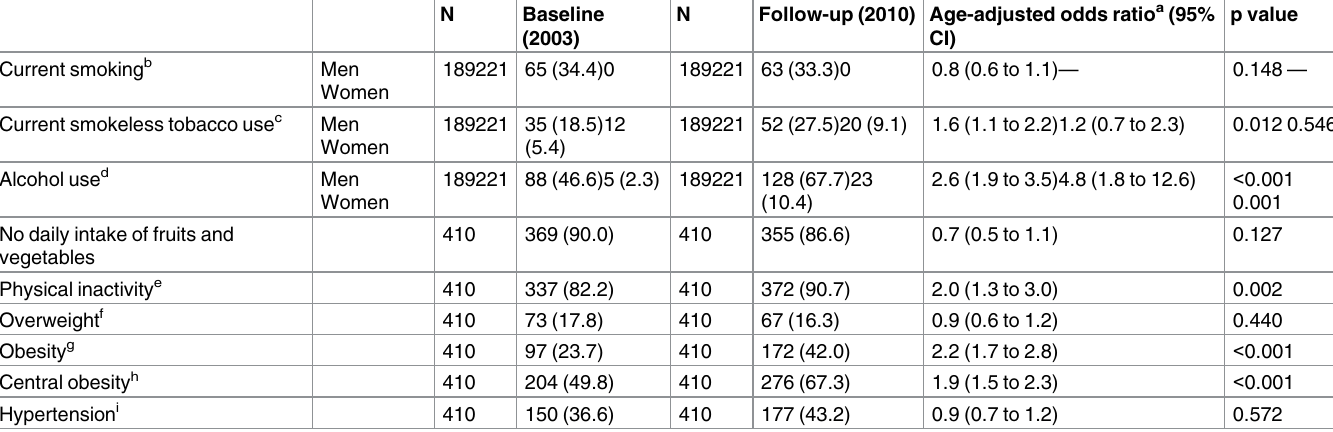
Table 3. Age-adjusted change in the prevalenceof risk factors for non-communicable diseasesin the study